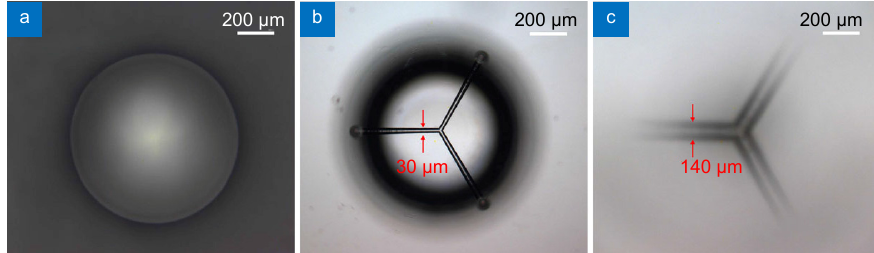
Fig. 10 | Optical micrograph. ( a ) Microlens. ( b ) Y-shaped microfluidic channel. ( c ) The enlarged image of the channel formed by the microlens. Figure reprinted with permission from ref. 73 ,